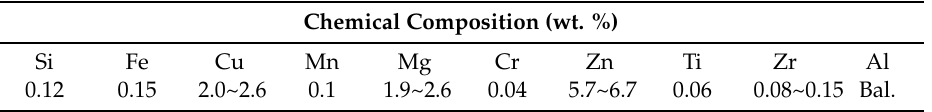
Table 1. Chemical composition (wt. %) of the 7050 aluminum